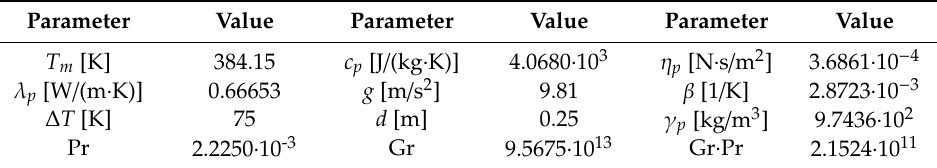
Table 3. Examples of Grashof and Prandtl (Gr ∙ Pr) calculation.